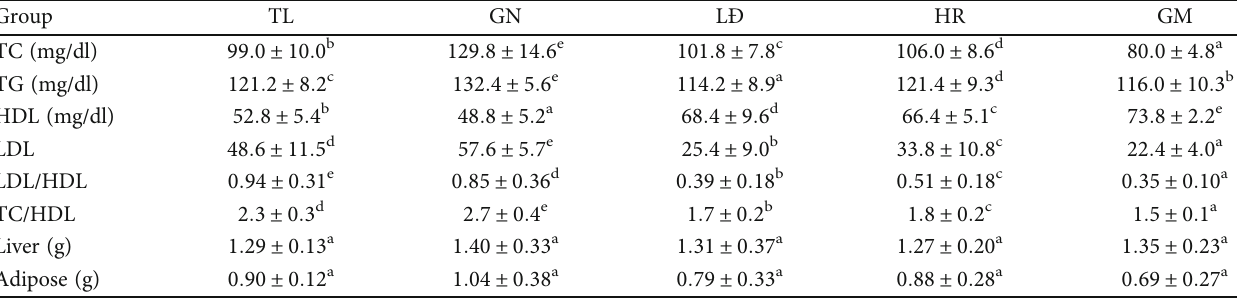
1 Di ff erent letters in the same row indicate signi fi cantly di ff erent means ( p < 0 : 05 ). Table 4: Total cholesterol (TC), high-density lipoprotein cholesterol (HDL), low-density lipoprotein cholesterol (LDL), triglycerides (TG), weight of liver, and adipose tissues of mice after 5 weeks of feeding HFD 1